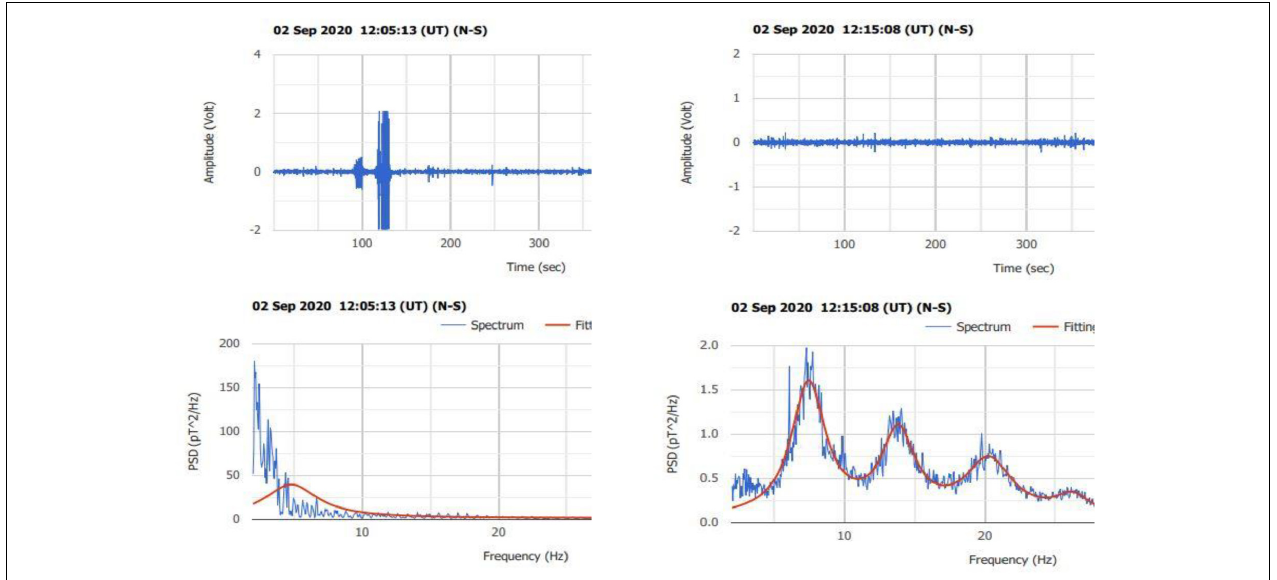
FIGURE 11 | Left panel : peculiar features due to five strong knocks on the door and five more on the window of the building in the south site. Right panel : spectrum recovery 10 min later.